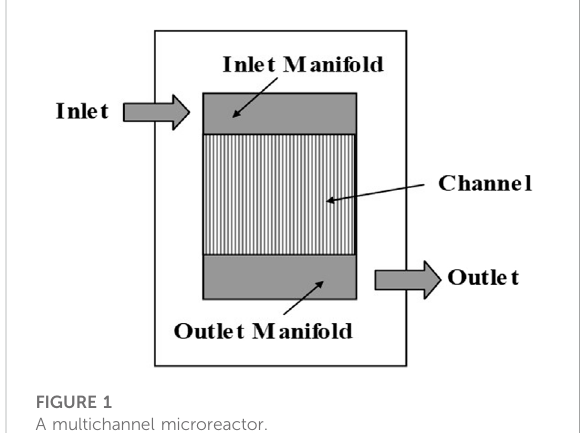
FIGURE 1 A multichannel